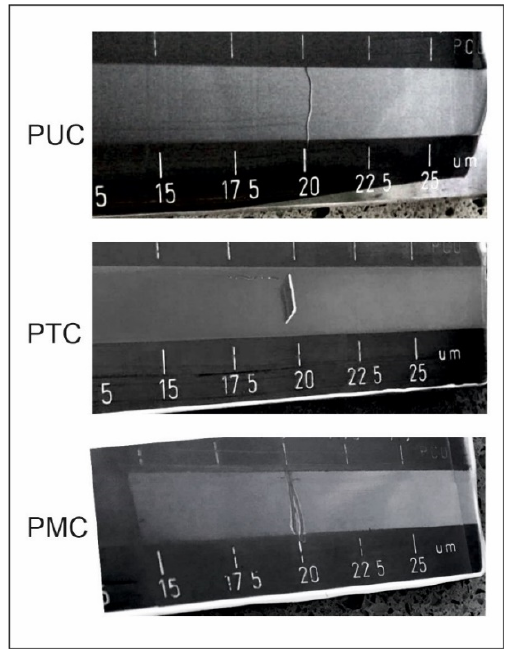
Figure 2. Streaks of coatings on the grid gauge channels.